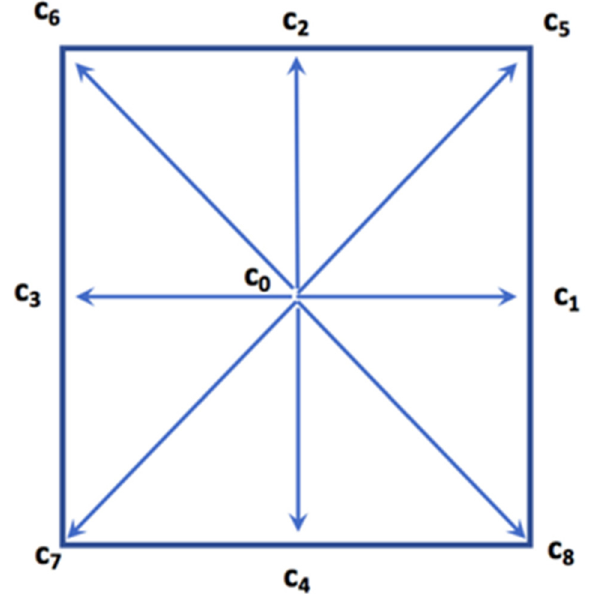
Figure 2. The D2Q9 lattice scheme.